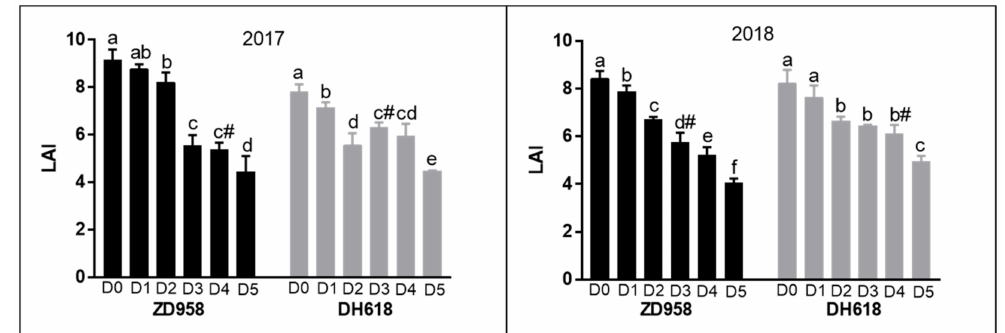
Figure 2. Leaf area index (LAI) of maize cultivars ZD958 and DH618 under di ff erent treatments at silking in 2017 and 2018. Within each year, di ff erent lowercase letters of the same cultivar above the columns showed the significant di ff erence between each treatment at P < 0.05. # denotes treatments with highest grain